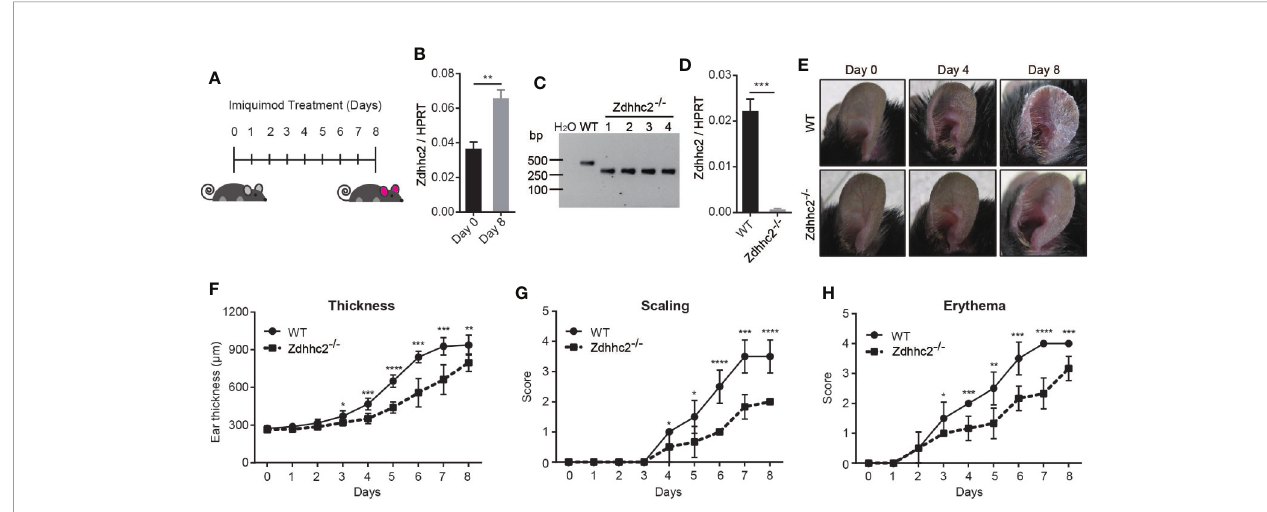
FIGURE 1 | Assessment of psoriasis symptoms induced by imiquimod in Zdhhc2 knockout mice. (A) Schematic representation of imiquimod stimulation on mice ear. (B) Zdhhc2 expression level was analyzed by qRT-PCR in ear skin of WT mice with (8 days) or without (0 days) imiquimod treatment (n = 3, mean ± SEM). (C) Zdhhc2 knockout mice were screened by PCR using tail genomic DNA of Zdhhc2 − / − mice. Results from Zdhhc2 − / − mice were shown and compared to